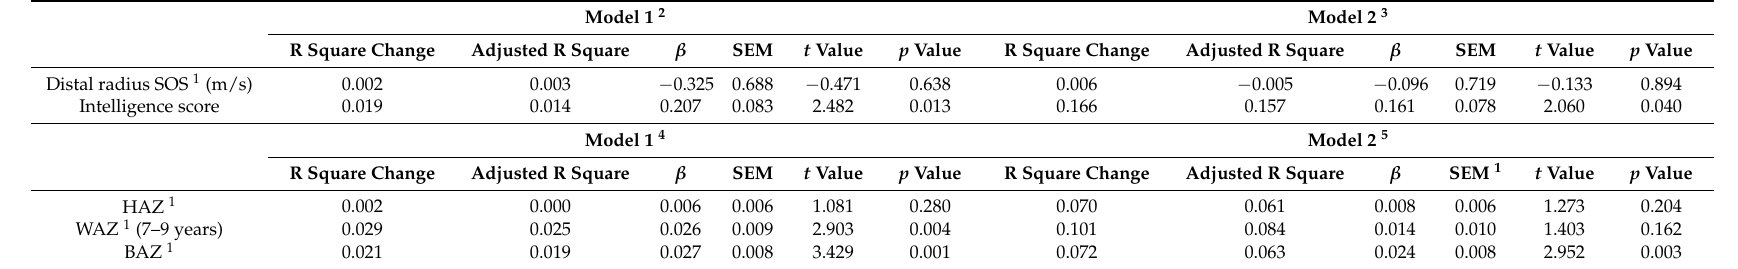
Table 5. Associations between vitamin D concentration and growth and development